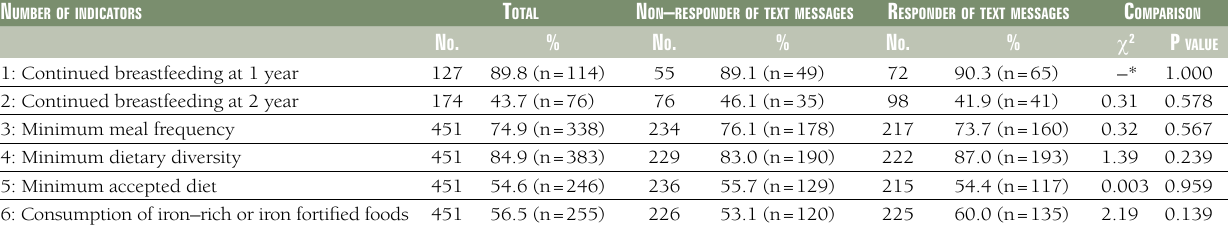
Table 5. IYCF indicators based on face–to–face